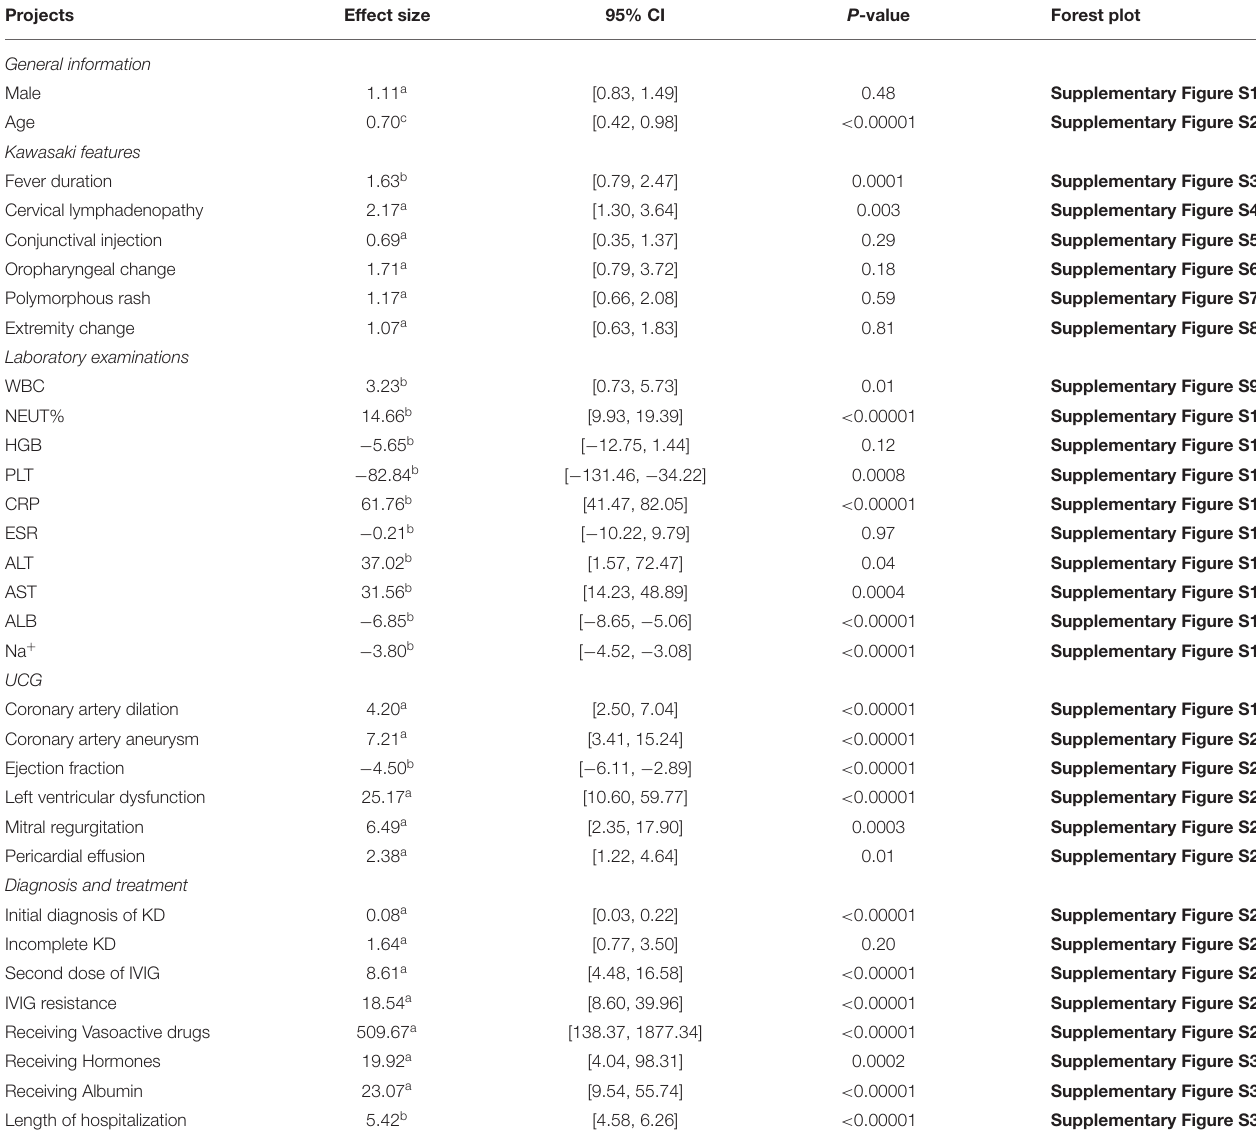
TABLE 2 | Results of